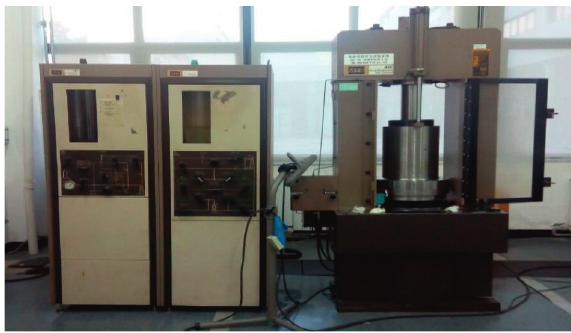
Figure 3: MTS815.02 rock mechanics test system.